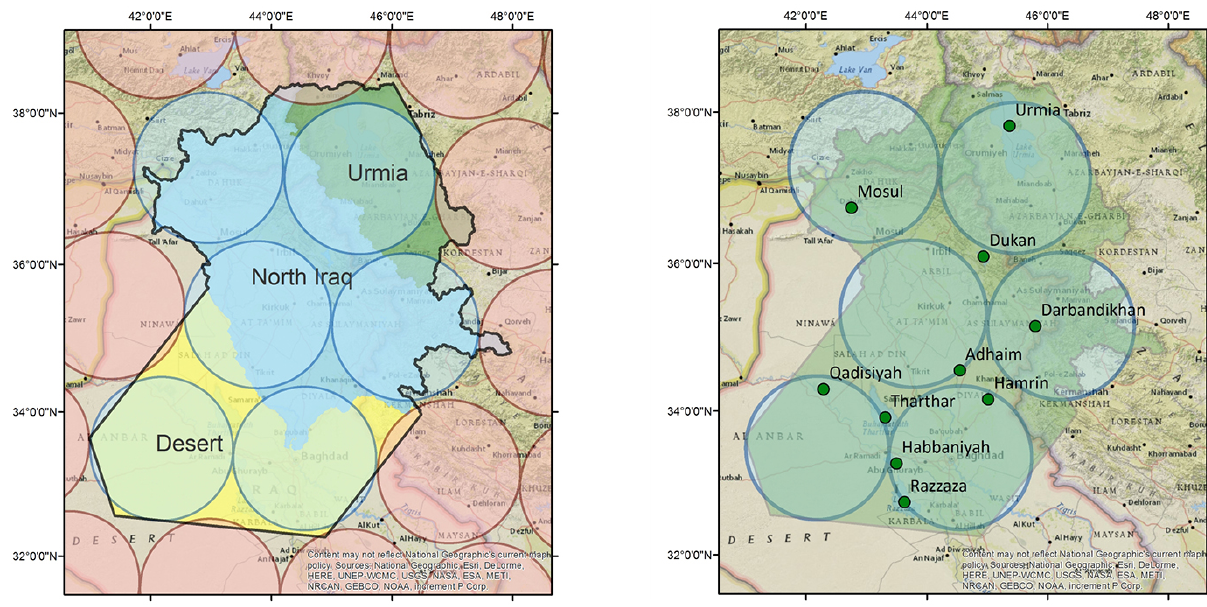
Figure 2. (left) Mascon coverage area for GRACE calculations. In the southwest the included desert area and in the northeast the included Urmia catchment. The blue circles show the coverage of the mascons used and the red circles mascons outside the study area. (right) Map of the total study area including the used mascons and